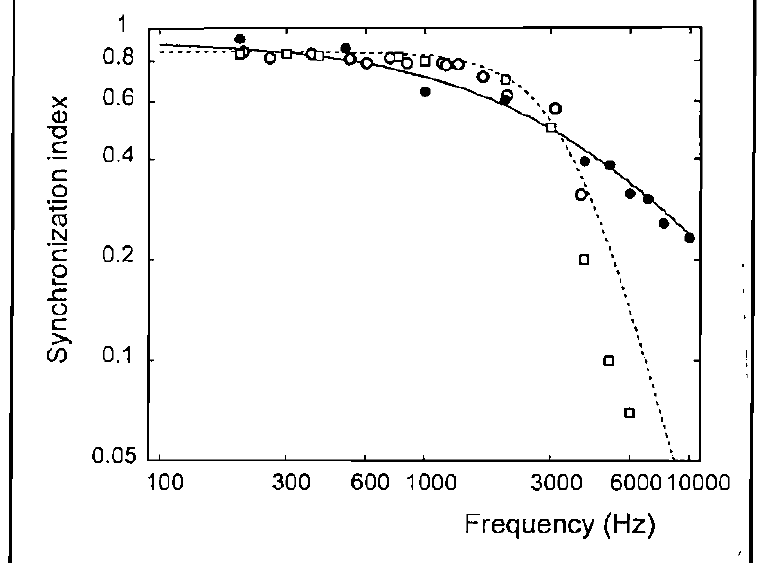
FIGURE 1. Synchronization index as a function of frequency for electrical and acoustic stimulation. The solid curve (electrical stimulation) was calculated from equation 4. The dotted curve (acoustic stimulation) was calculated from equation 2. Open squares are data from Johnson (1980) and open circles are data from Javel and Mott (1988) for acoustic stimulation. Filled circles are data for sinusoidal electrical stimulation from Dynes and Delgutte